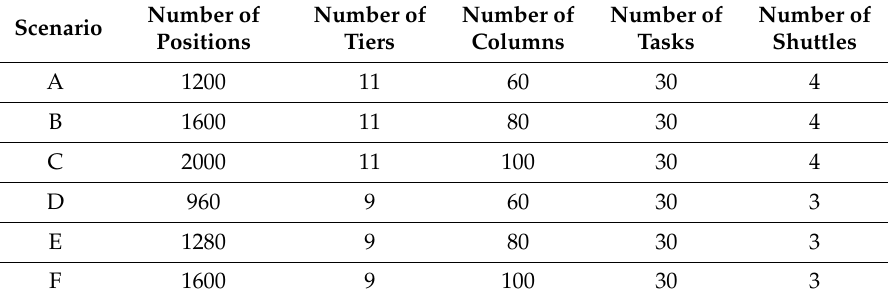
Table 4. Scenario settings.